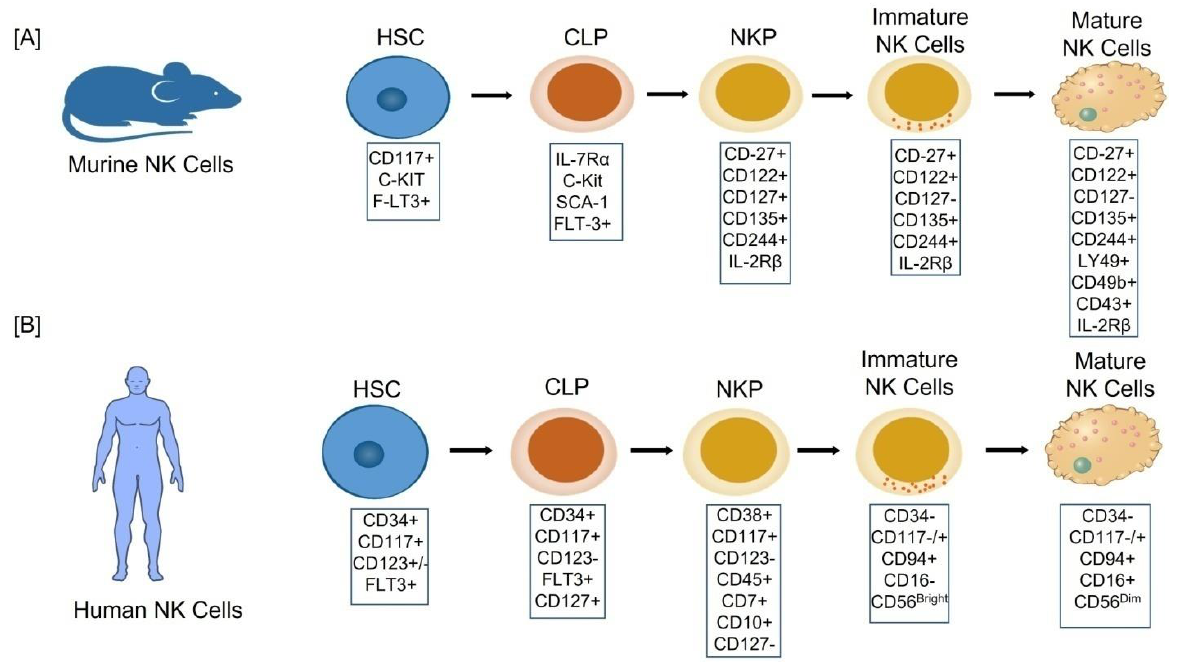
Figure 1. Cellular stages of Natural Killer (NK) cell development: ( A ) murine; ( B ) humans. In both cases the NK cells develop in the bone marrow from the common progenitor hematopoietic stem cells (HSC) and pass through the five different cellular stages to become a mature NK (mNK) cell, each of which is characterized by the different surface markers. CLP: Common lymphoid progenitor cells. NKP: Natural killer progenitor cells.